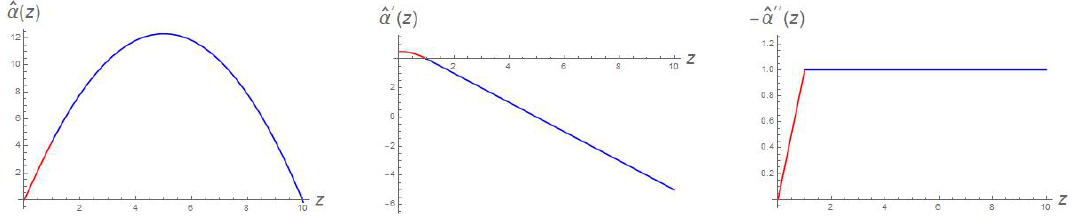
Figure 15. ^ (cid:11) ( z ) and its (cid:12)rst and second derivatives, for the dual background of the quiver in (cid:12)gure 5.